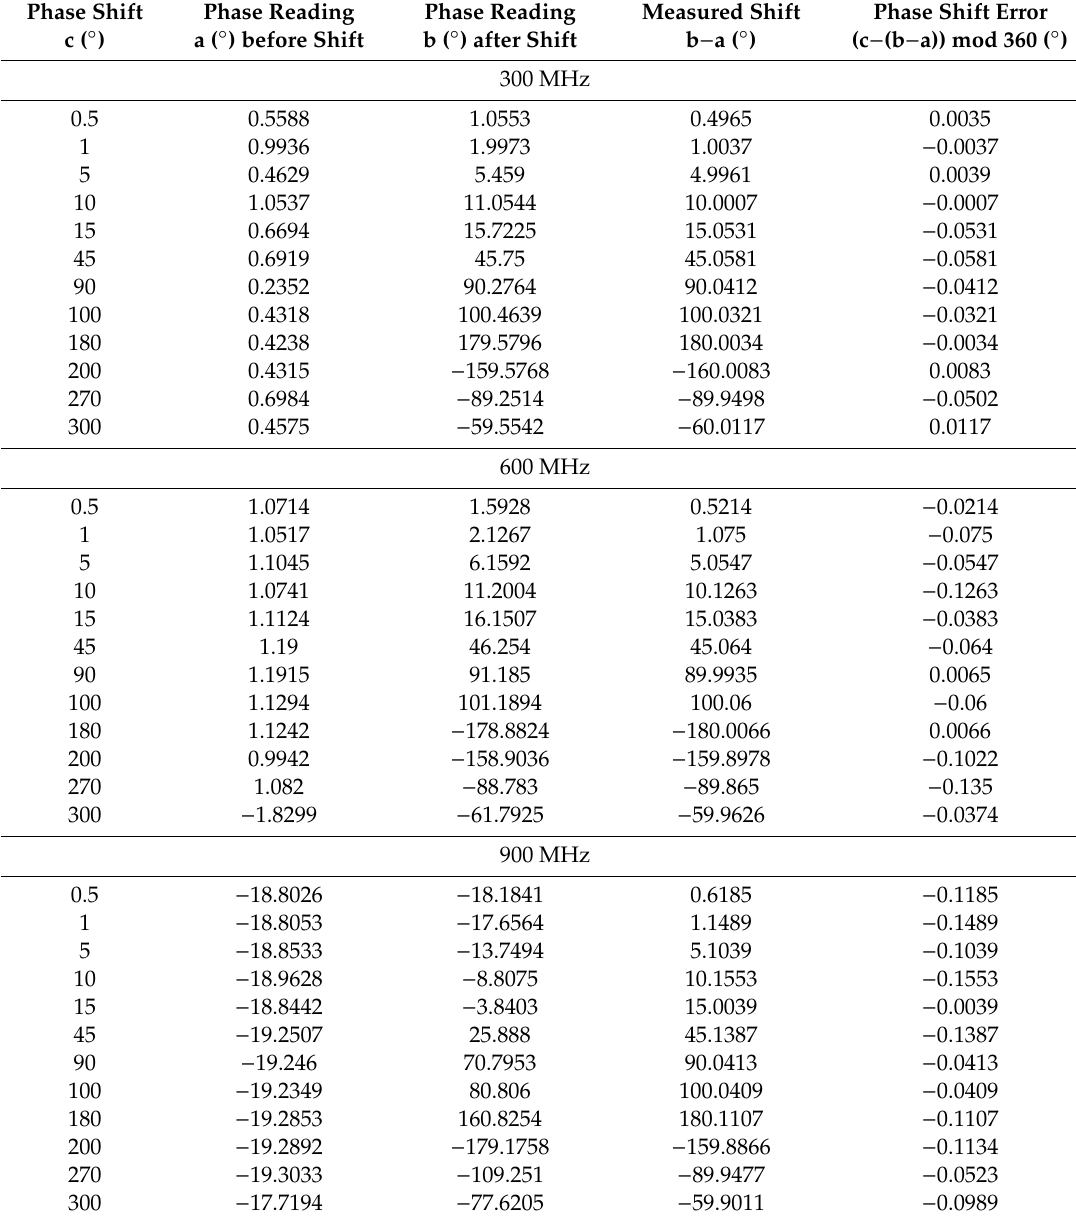
Table 2. Test results of the phase shift